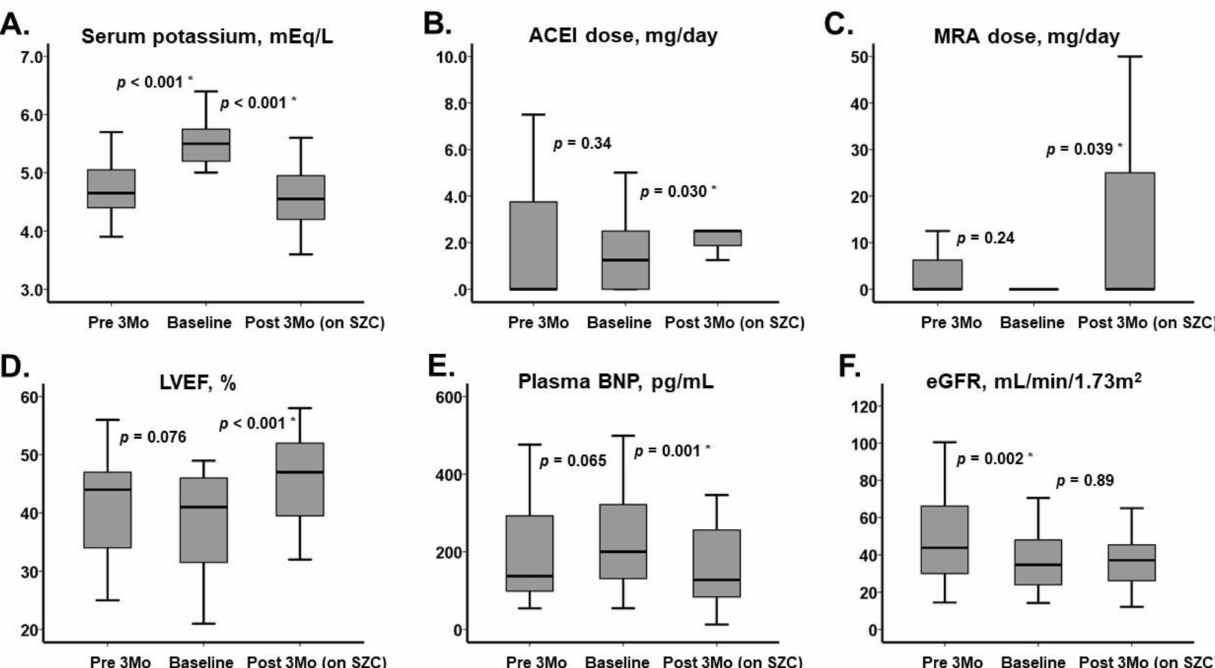
Figure 1. Trends of major clinical parameters including serum potassium level at 3 time points (pre 3 months, baseline, and post 3 months on SZC). ( A ) Serum potassium, ( B ) ACEI dose, ( C ) MRA dose, ( D ) LVEF, ( E ) Plasma BNP, ( F ) eGFR. ACEI, angiotensin-converting enzyme inhibitor; MRA, mineralocorticoid receptor antagonist; LVEF, left ventricular ejection fraction; BNP, B-type natriuretic peptide; eGFR, estimated glomerular filtration ratio. * p < 0.05 by Wilcoxon signed-rank test.